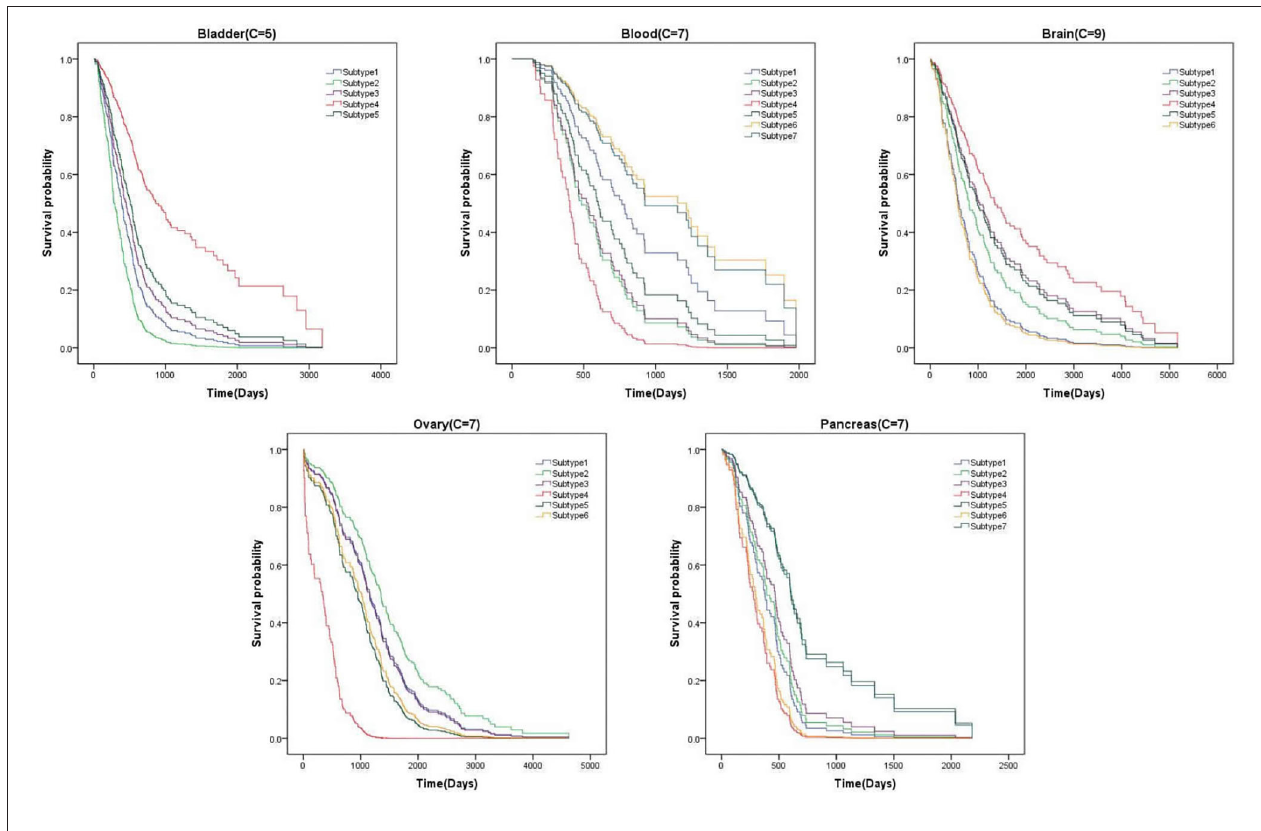
FIGURE 5 | Survival curve on the novel dataset.